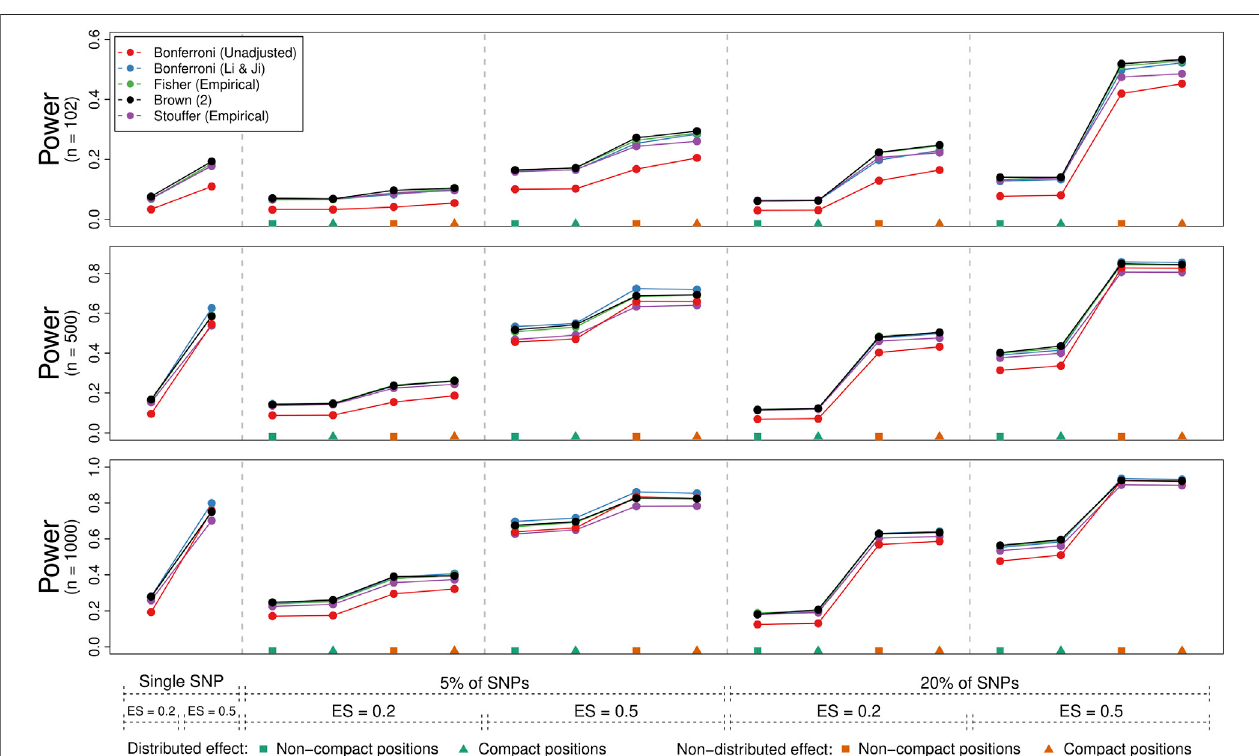
FIGURE 4 | Power comparison of fi ve methods for gene-based testing for three different sample sizes ( n = 102, 500, and 1000). The points represent the average rejectionrateofamethodunderaspeci fi cscenarioasindicatedbythelabels/symbolsunderthe x -axis(number/percentofSNPsthatareassociatedwiththephenotype, the effect size,whether theeffect wasdistributed over the signi fi cantSNPs, and whether signi fi cantSNPs were compactly positioned withinthe genes). Brown (2) refers to the two-sided version of Brown ’ s method (i.e., Eq. 13 ).